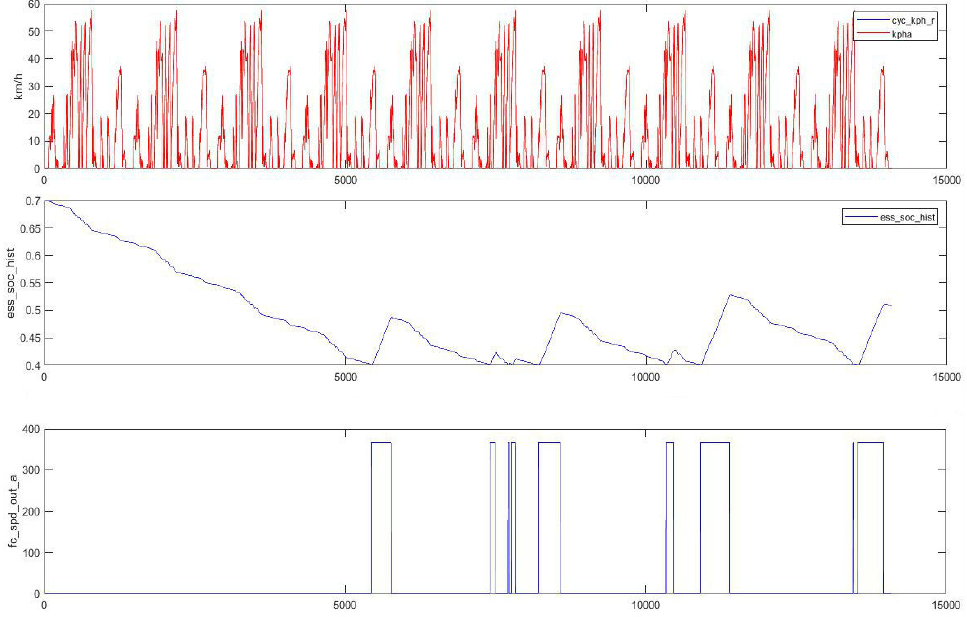
Figure 6. Speed profile (up) (km / h), SOC history (center) and time interval in which the MGT operates in ON-OFF logic (down) in the urban cycle.